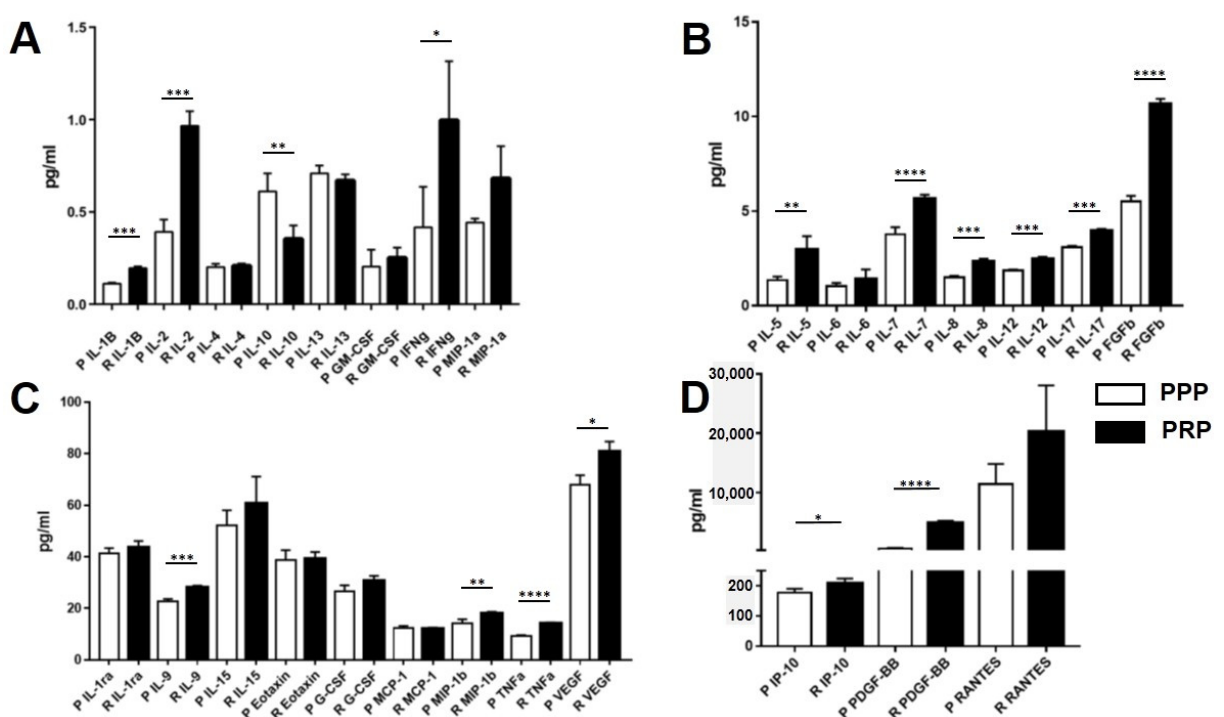
Figure 1. Profiles of cytokines, chemokines, and growth factors in PRP and PPP of knee OA patients at various concentrations: ( A ) 0–1.5 pg/mL; ( B ) 1.5–15 pg/mL; ( C ) 15–80 pg/mL; ( D ) 100–30,000 pg/mL. Abbreviations: OA, osteoarthritis; PRP, platelet-rich plasma; PPP, platelet-poor plasma. * p < 0.0 5, ** p < 0.01 , *** p < 0.001 , **** p < 0.0 00 1.